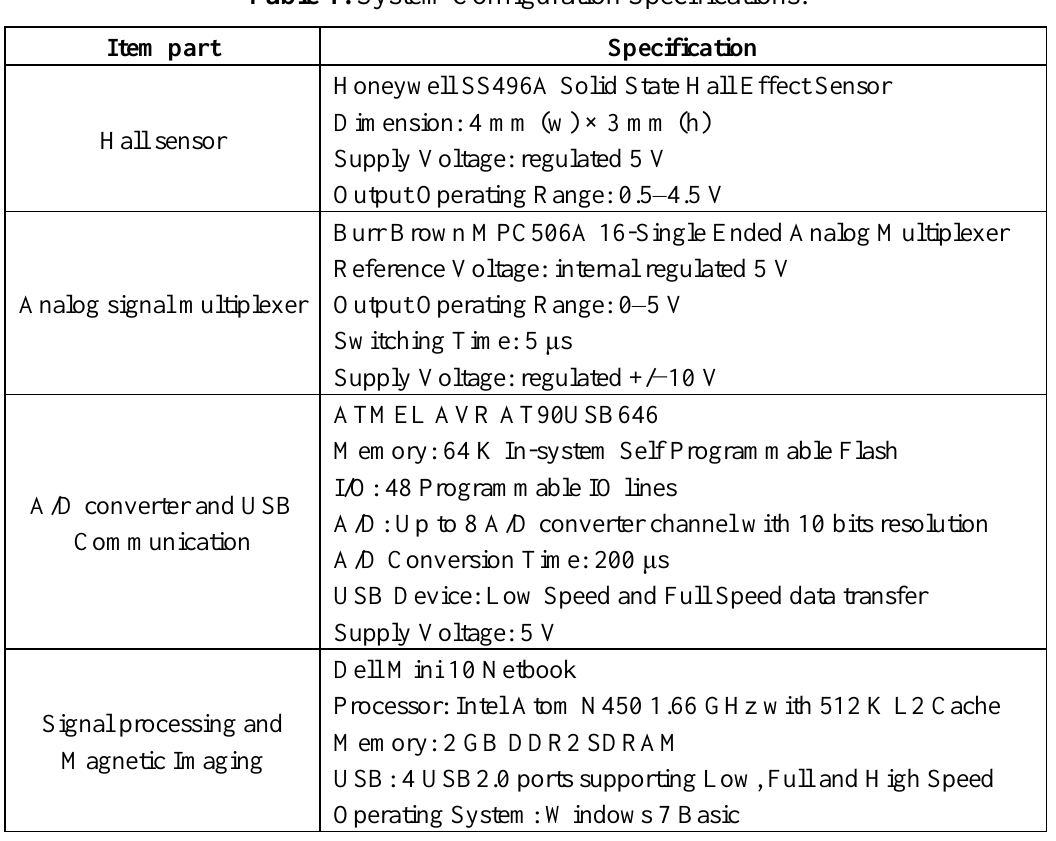
Table 1. System Configuration